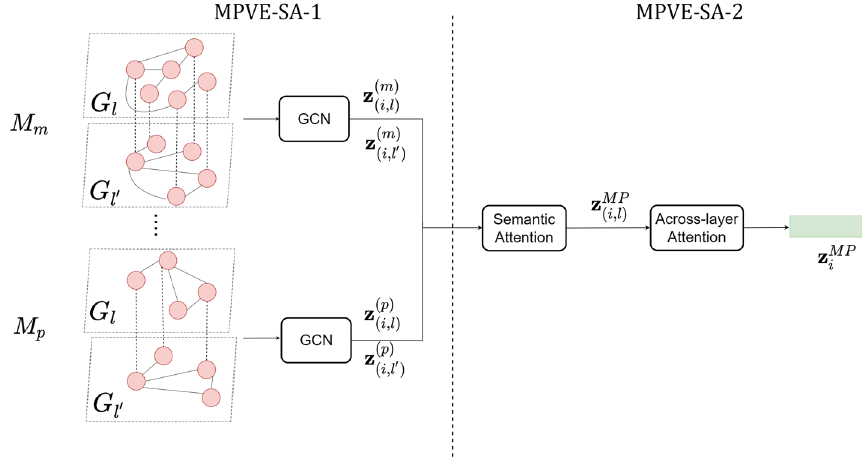
Fig. 8 Illustration of the sub-steps of the Co-MLHAN-SA embedding generation under the meta-path view of the entity v